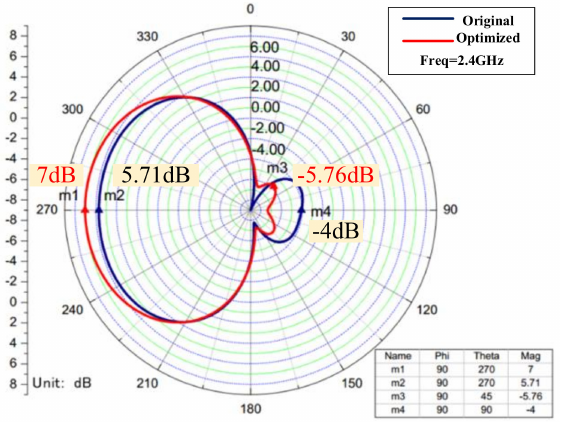
Figure 13. Comparison of transmitting antenna patterns before and after